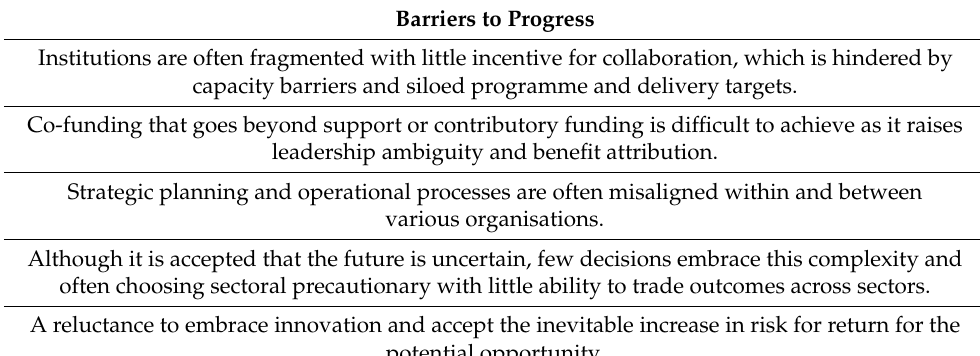
Table 1. Barriers that emerged from the initial survey among the C5a partnership. Barriers to